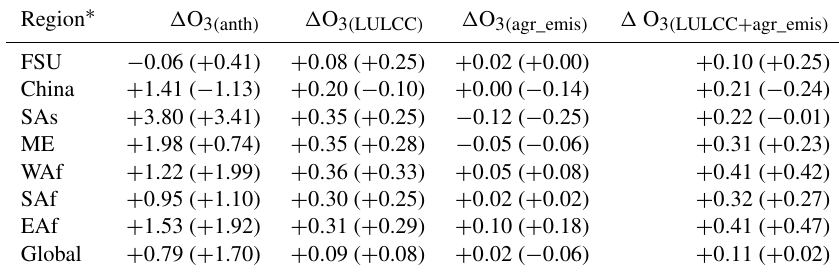
Table 4. Changes in area-averaged and population-weighted (in parentheses) annual mean surface O 3 concentrations (in ppbv) due to anthro- pogenic emissions alone ( (cid:49) PM 2 . 5 ( anth ) ) , LULCC ( (cid:49) PM 2 . 5 ( LULCC ) ) , agricultural emissions ( (cid:49) PM 2 . 5 ( agr_emis ) ) , and the combined effects of LULCC and agricultural emissions ( (cid:49) PM 2 . 5 ( LULCC + agr_emis ) ) together. Results only from regions with population-weighted average